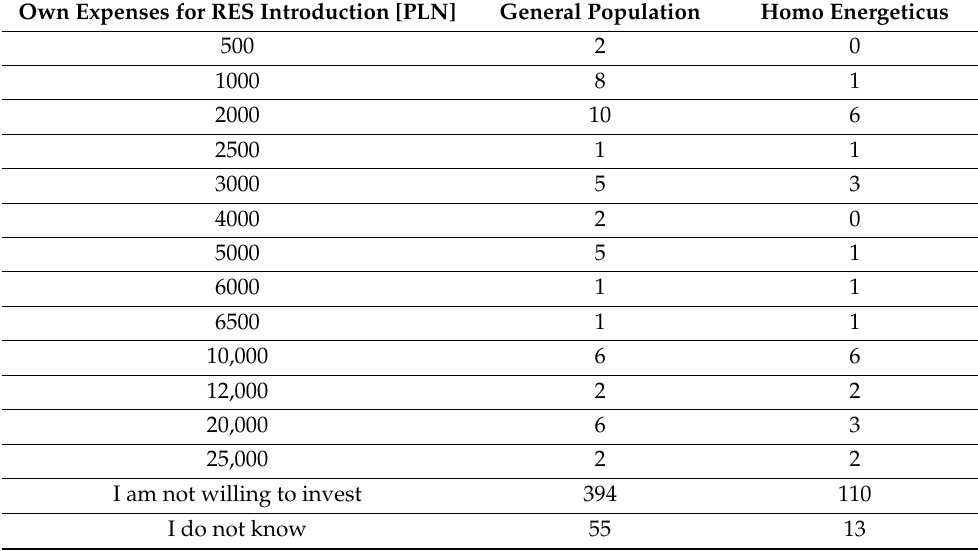
Table 5. The volume of own expenses for RES introduction: the comparison of responses from the entire studied population and homo